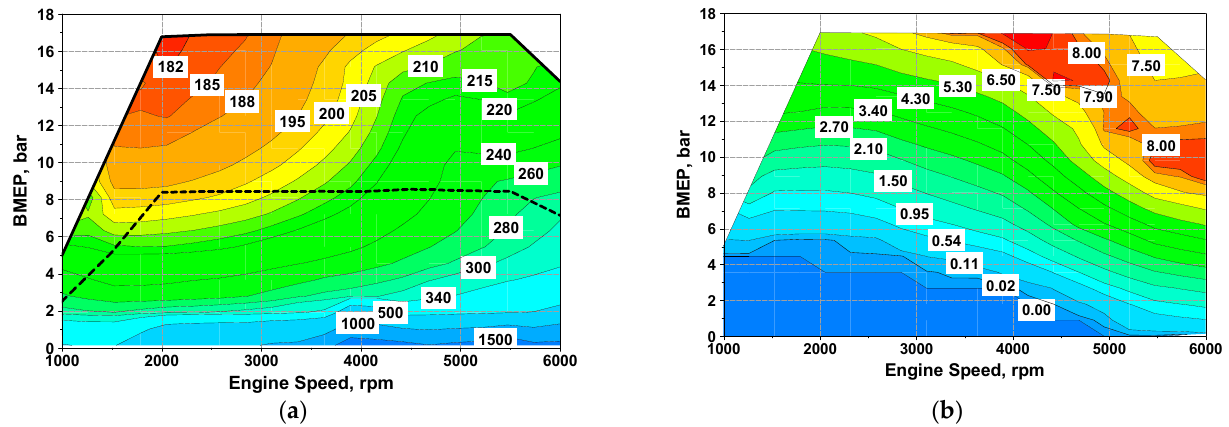
Figure 2. Maps of thermal engine 1 brake specific fuel consumption (BSFC), g/kWh, ( a ) and E-compressor power con- sumption, kW, ( b ).